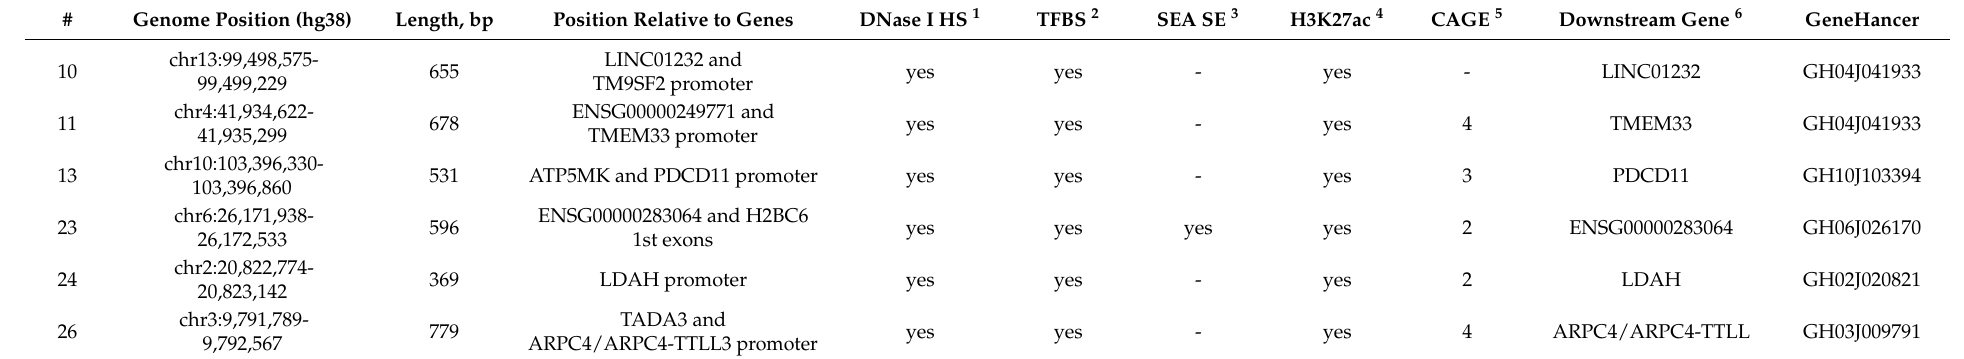
Table 1. Sequenced and mapped DNA fragments from L1